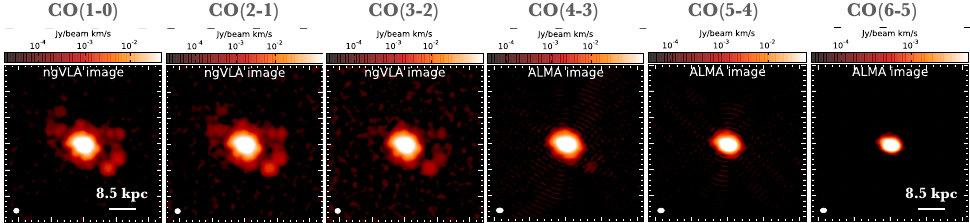
Figure 5. Simulated ngVLA and ALMA CO emission line maps for CO J = 1 → 0 to J = 6 → 5 transitions. As illustrated by the simulation, access to the low- J transitions by the ngVLA is critical to capture the distribution of the diffuse emission associated with spiral arms in this z = 2 galaxy. In contrast, the ALMA-traced higher lying transitions primarily capture the warm, actively star-forming gas associated with the nuclear regions [Adapted from D. Narayanan et al., ngVLA memo